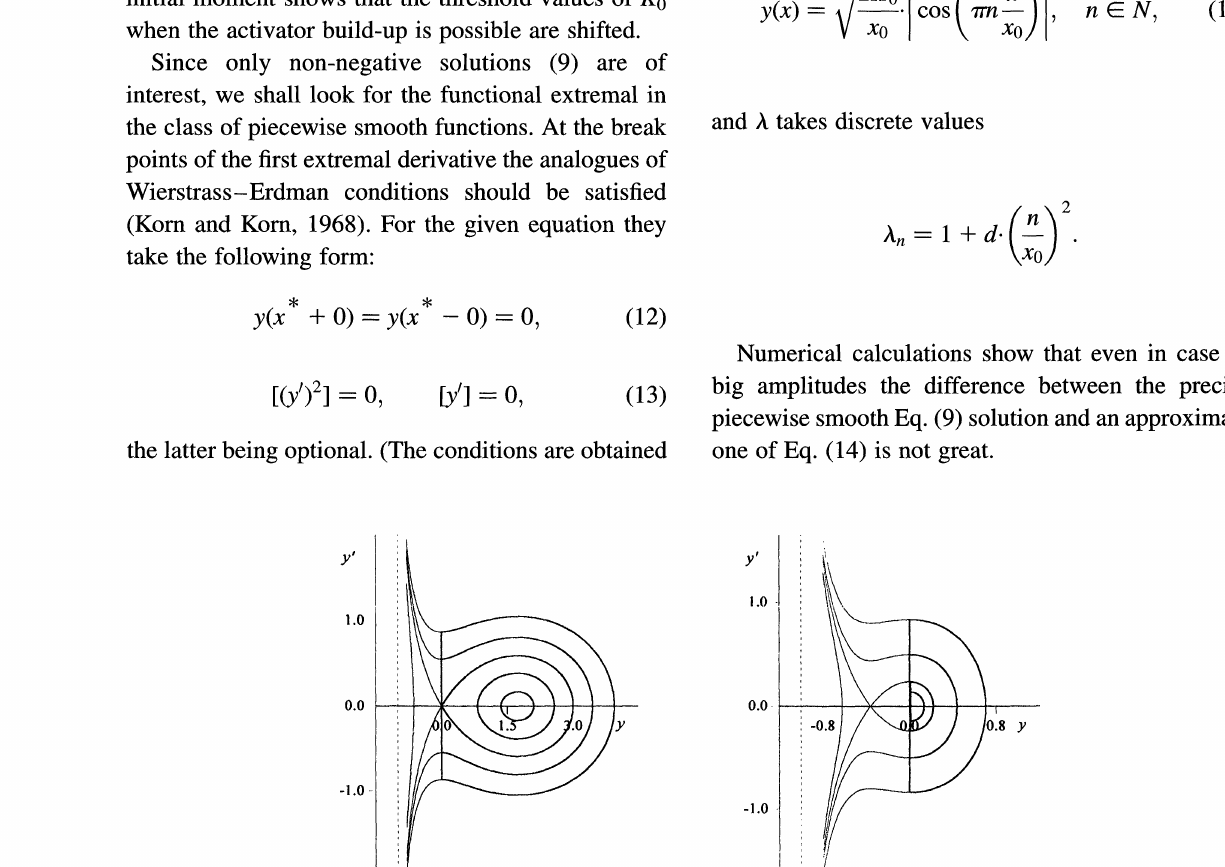
FIGURE 6 Phase diagrams of Eq. (9) with conditions (12) and(13): (a) when A > (atA 2); (b)when0 < A < (atA 0.5). The phase trajectories are shown by thick color lines. The dashed line is an asymptote y -1. The red line represent separatrisses of the